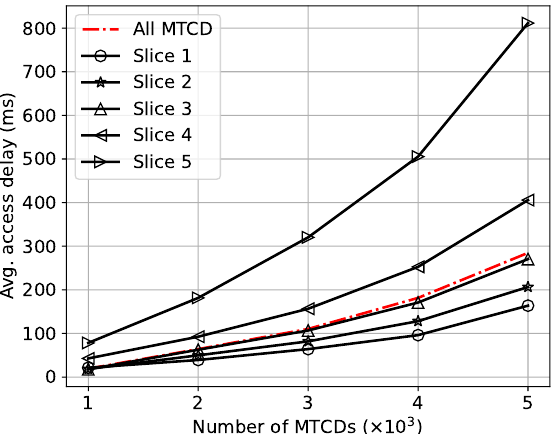
Figure 6. Average access delay vs. the number of MTCDs.